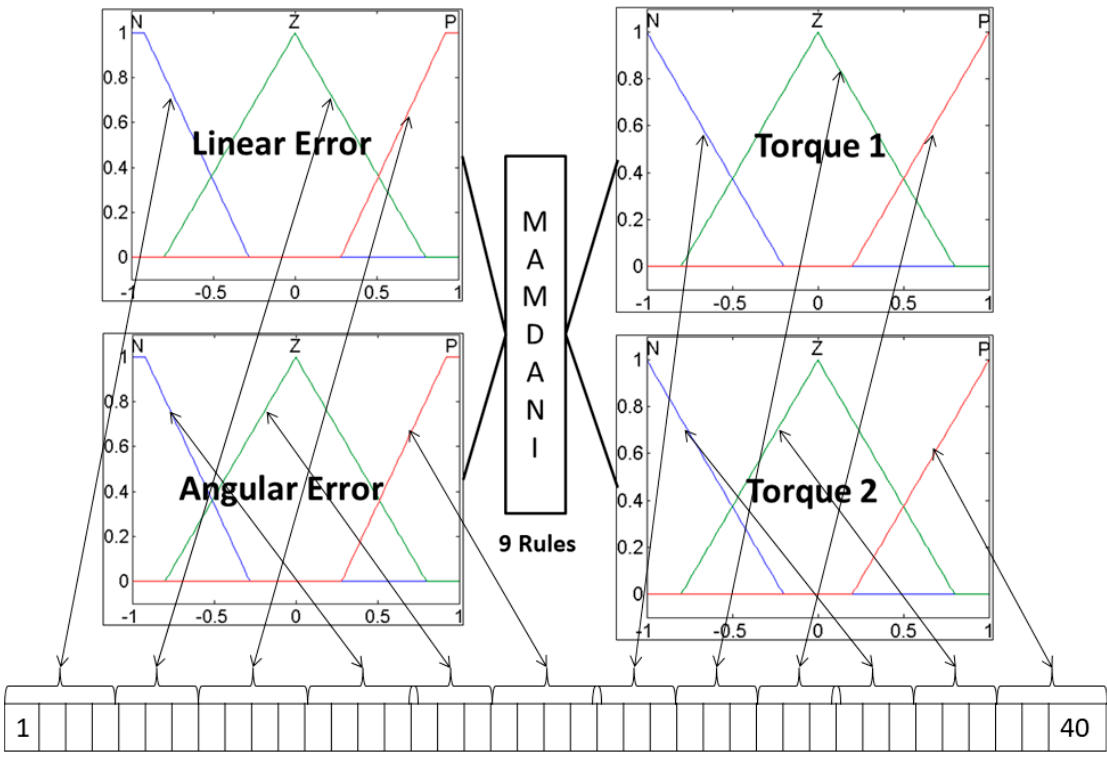
Figure 13. Optimization problem (points of the membership functions).